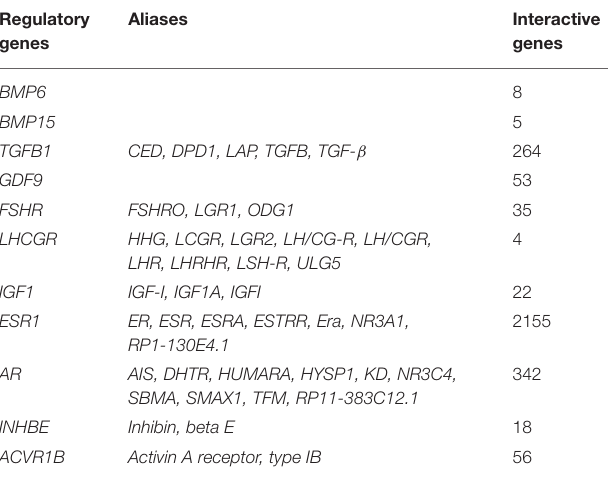
TABLE 1 | Interactive genes identified via BioGRID according to regulatory proteins secreted by oocytes and maternal upstream regulatory protein. Regulatory Aliases Interactive genes